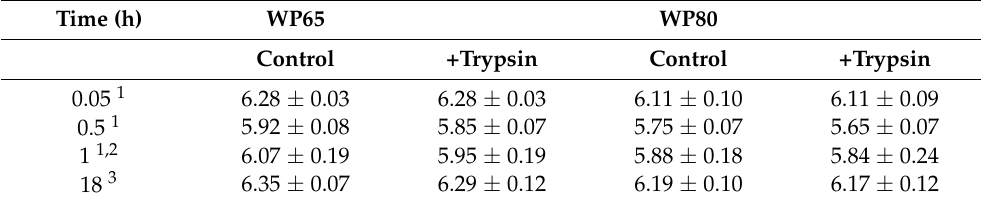
Table 3. pH changes during hydrolysis and storage of tryptic hydrolysates of 5% ( w / w ) solutions of WPC powders of sheep/goat origin manufactured from Feta cheese whey. Codes are explained in Section 2.1.